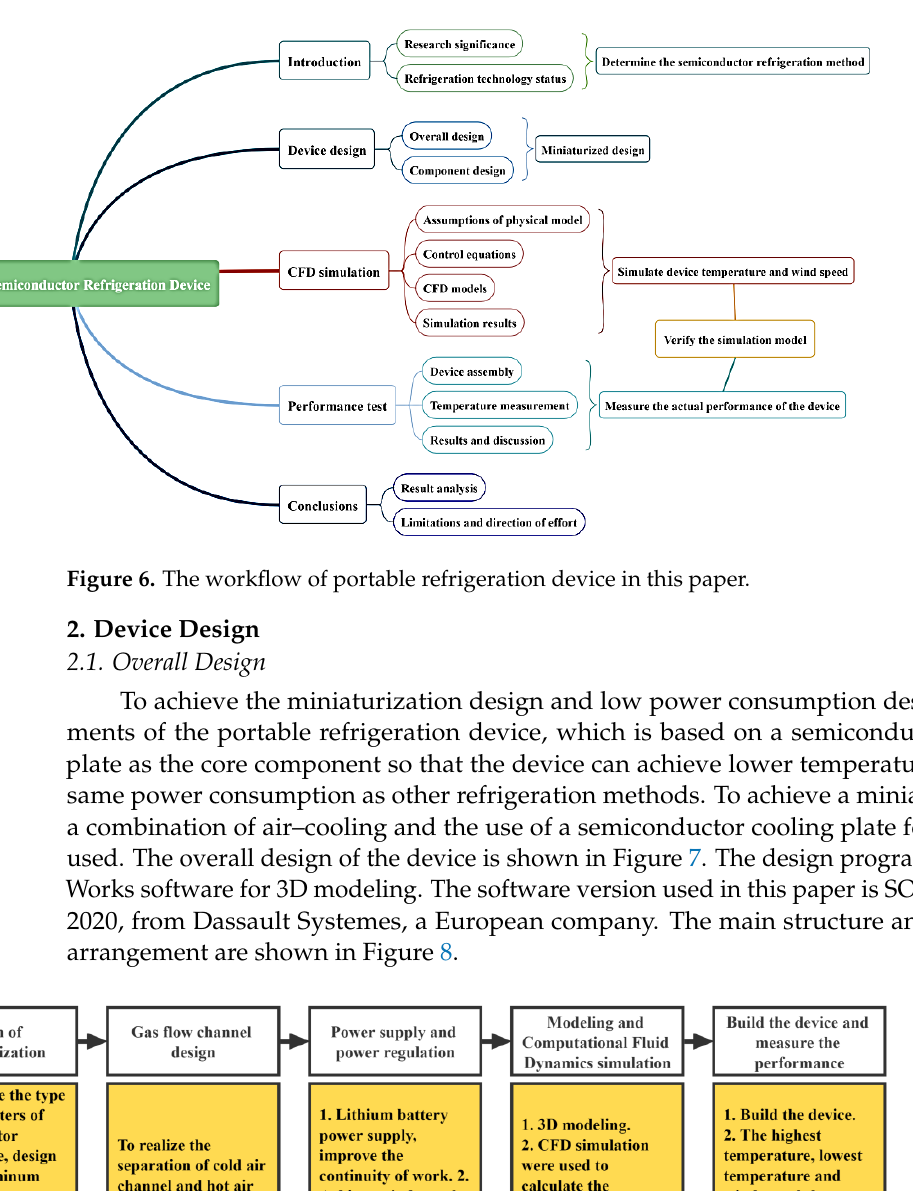
Figure 5. Comparison of different refrigeration methods.